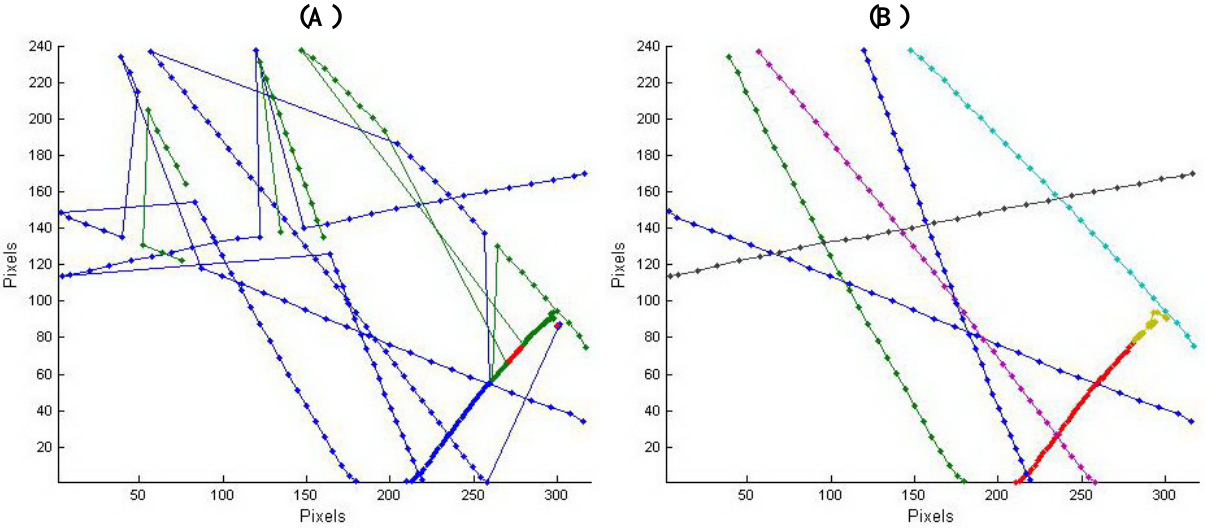
Figure 7. The effect of the sorting algorithm, (A) unsorted object tracings and (B) sorted object tracing. Objects in (B) are aligned and separated from each other, whereas in (A) connections between objects